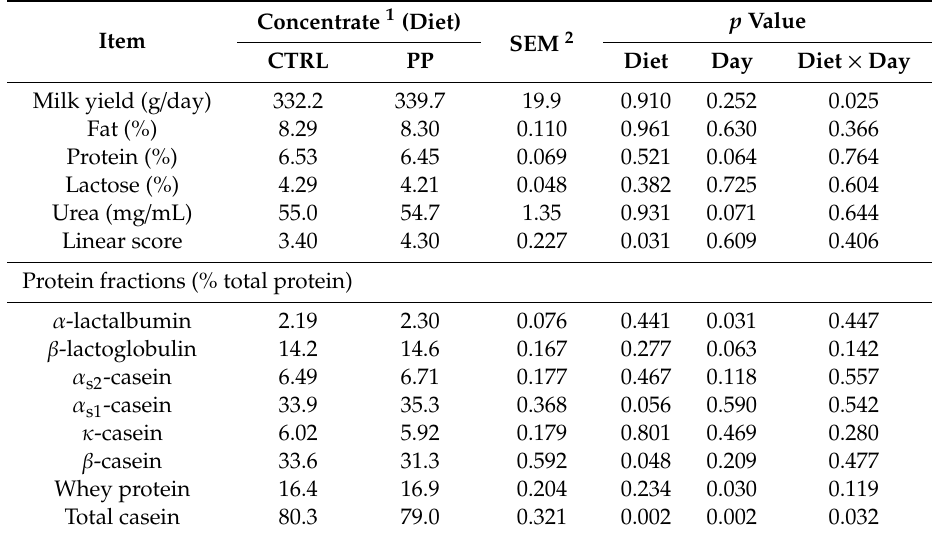
Table 2. E ff ect of the inclusion of pomegranate pulp in the diet of lactating ewes on milk production and